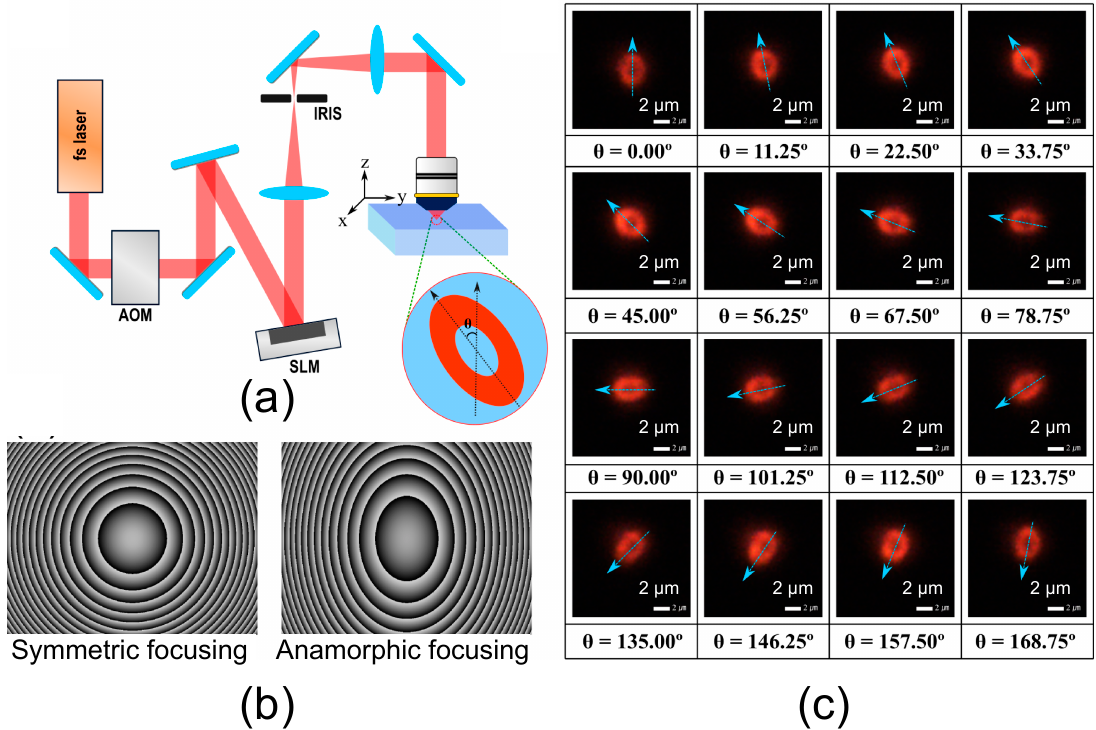
Figure 1. ( a ) Femtosecond laser tight focusing in the silver-containing glass, leading to the production of fluorescent silver clusters at its periphery. ( b ) SLM holographic phase masks with an additional cylindrical profile leading to an elliptical pattern by DLW. ( c ) Oriented elliptical patterns obtained by SLM phase mask manipulation, corresponding to 2 4 = 16 orientation-encoded levels.